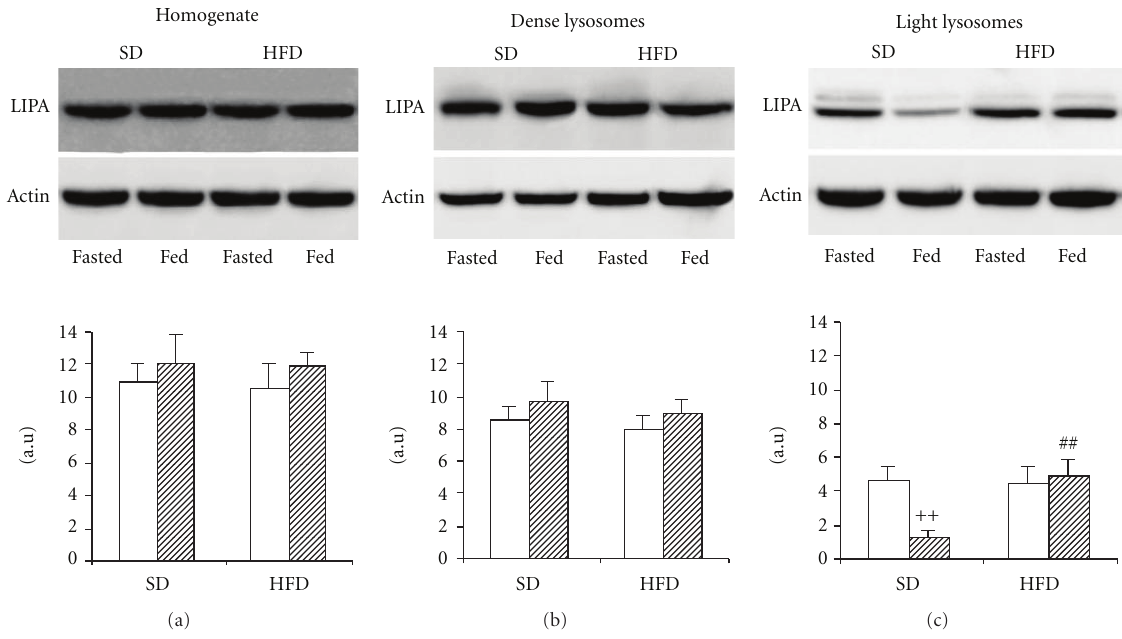
Figure 3: The e ff ect of HFD on the LIPA protein expression. (a) Homogenate; (b) dense lysosomes; (c) light lysosomes. Representative Western blots are shown above each graph (f = fasted, F = fed). The results are expressed as arbitrary units after normalisation to the actin expression (loading control). Open bars = fasted animals; hatched bars = fed animals. ++ P < 0 . 01 fed versus fasted; ## P < 0 . 01 HFD fed versus SD